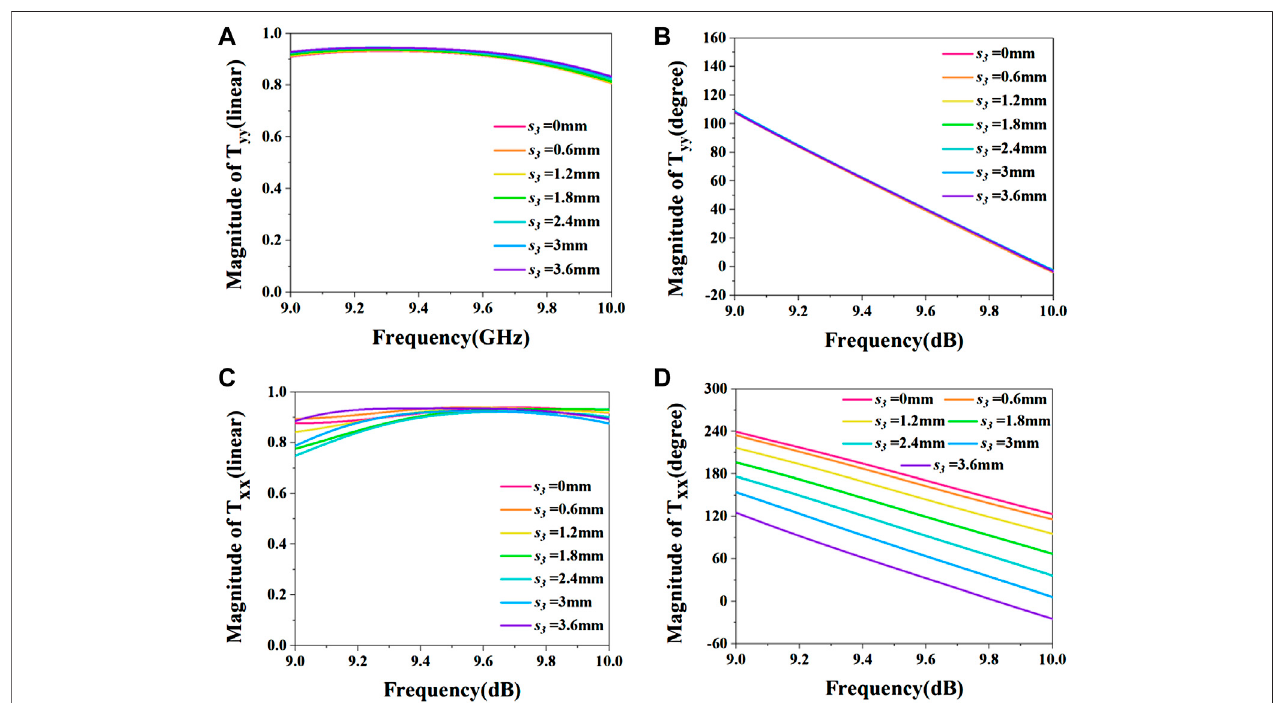
FIGURE3| Simulationresultsfordifferents 3 . (A) Emittingthey-polarized waveand theamplitudeofthetransmittedy-polarizedwavewithdifferents 3 . (B) Emitting the y-polarized wave and the phase of the transmitted y-polarized wave with different s 3 . (C) Emitting x-polarized wave and the amplitude of the transmitted x-polarized wave with different s 3 . (D) Emitting x-polarized wave and the amplitude of the transmitted x-polarized wave with different s 3 .